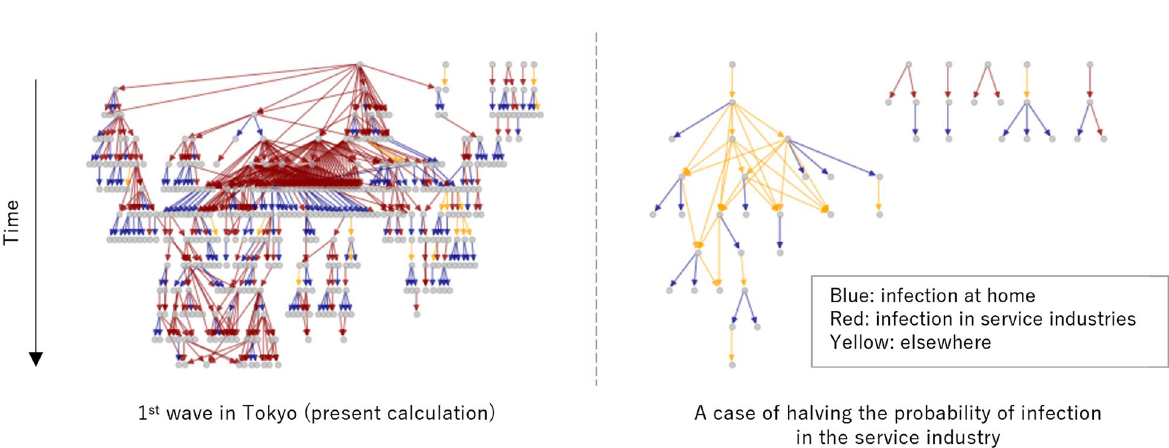
Figure 5. Infection network for agents. The left figure shows the infection network in Fig. 1. The right figure shows the infection network in the calculation results assuming that infection countermeasures have been taken in the service industry and the infection risk has been